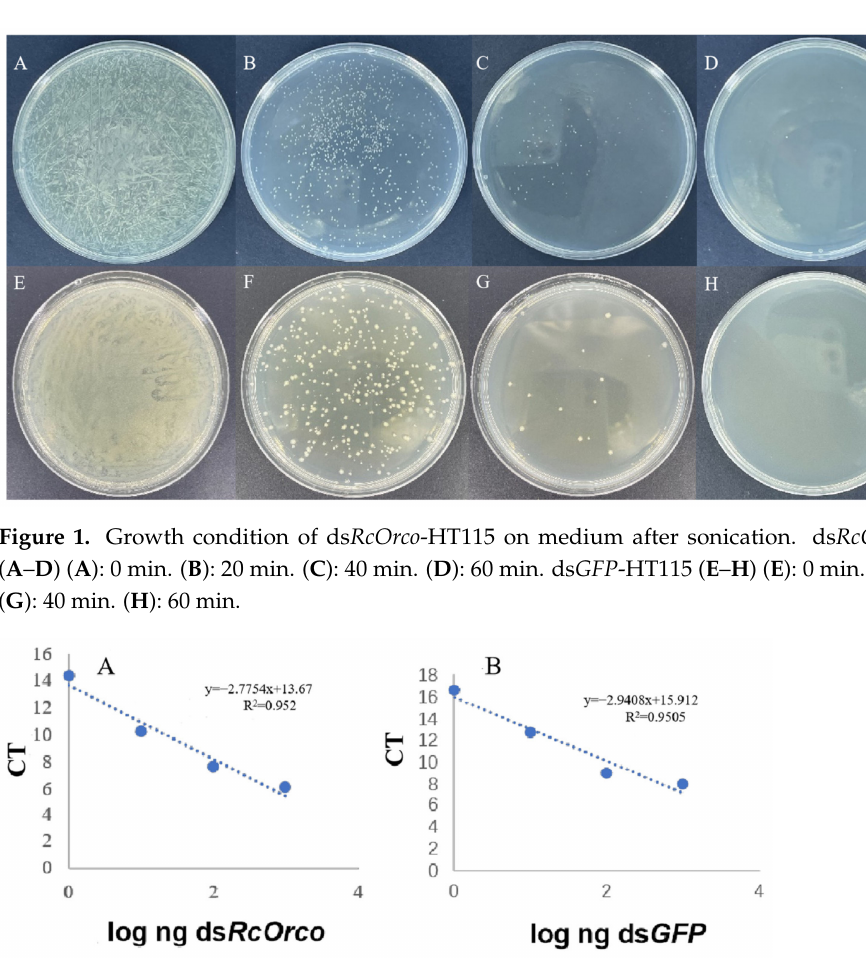
Figure 2. Standard curves of dsRNA ( A ) dsRcOrco and ( B ) dsGFP